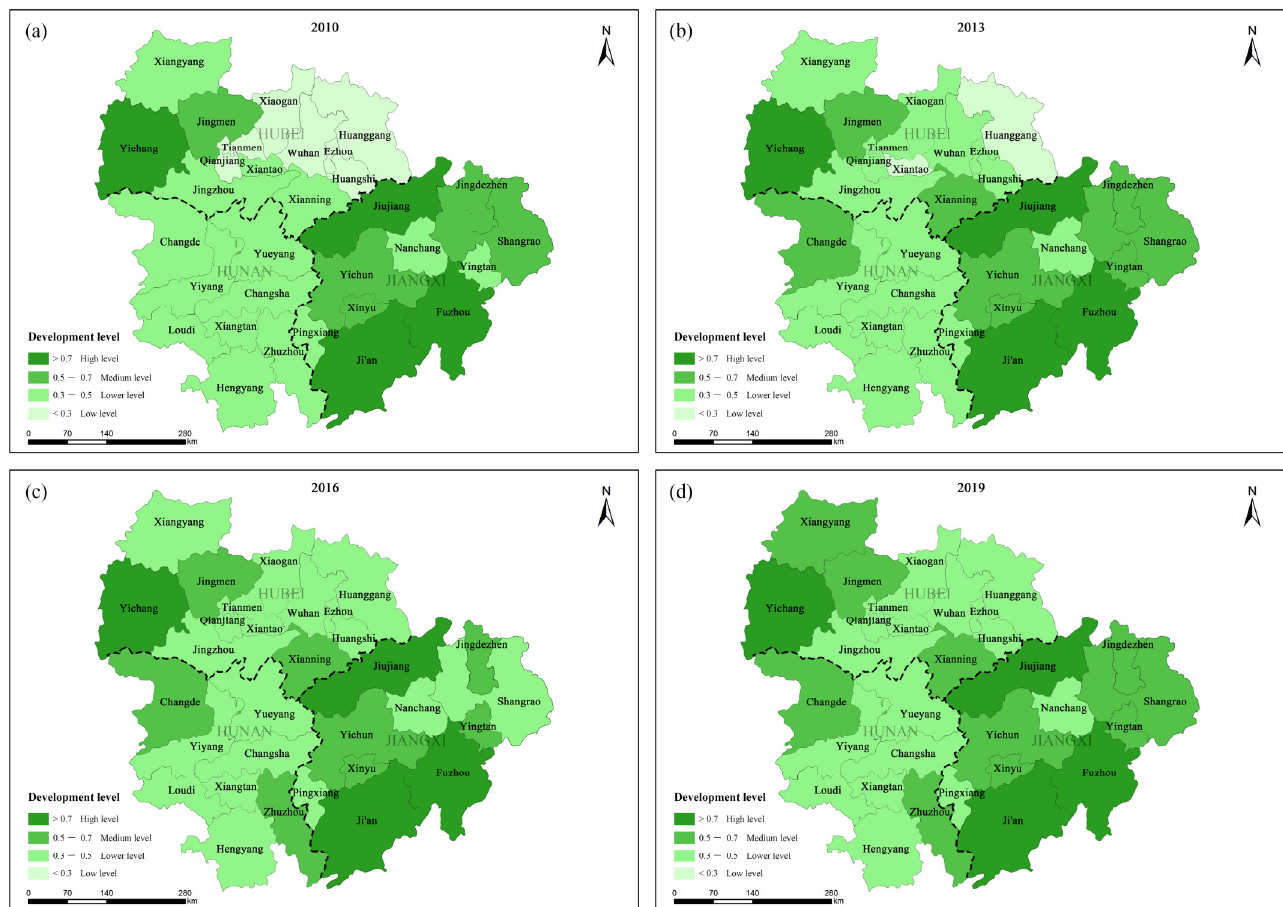
Figure 5. Temporal and spatial changes of the comprehensive assessment level of EE from: ( a ) 2010; ( b ) 2013; ( c ) 2016; ( d ) 2019.